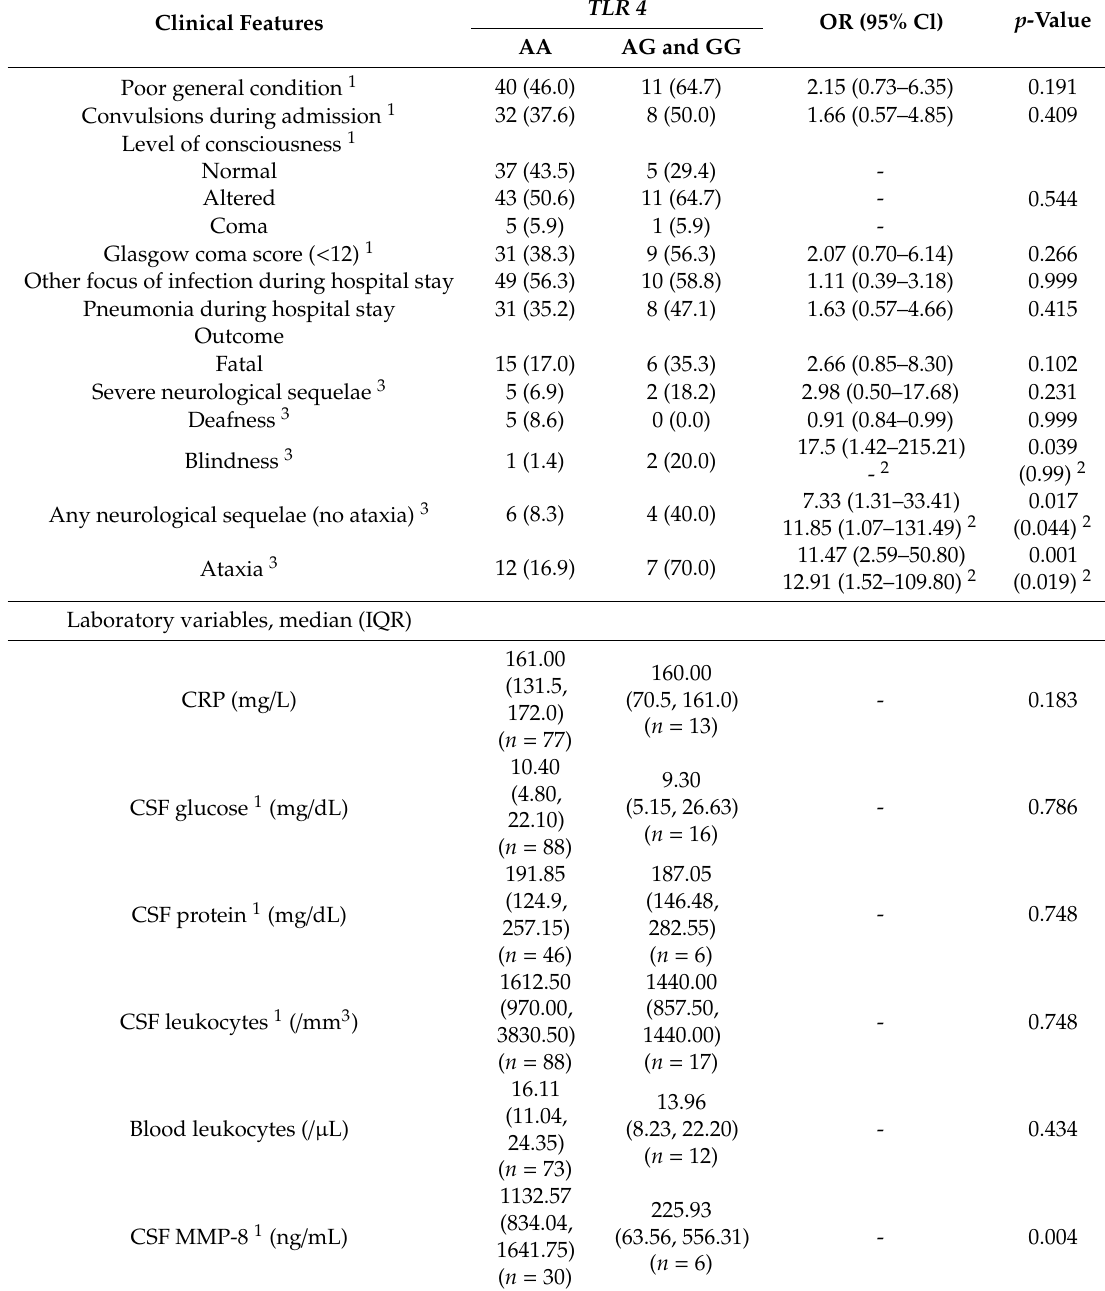
Table 4. Associations between the TLR4 (rs4986790) polymorphism and the laboratory values and severity factors of Gram-negative bacterial meningitis